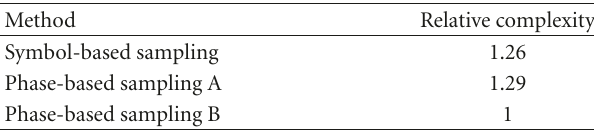
Table 1: Comparison of the complexity per sample of the Monte Carlo methods (for QPSK